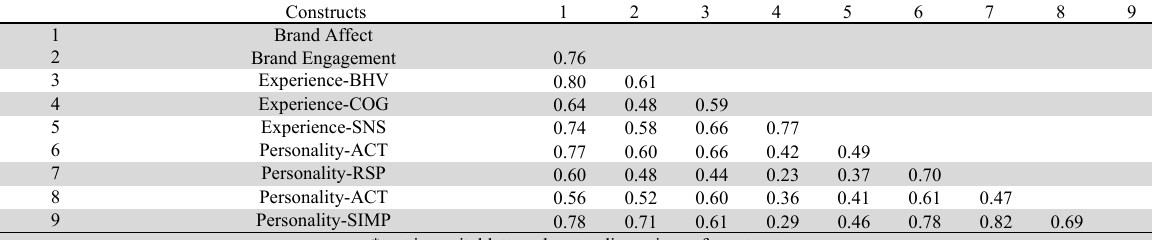
HTMT Criterion Values – 1st Stage of Measurement